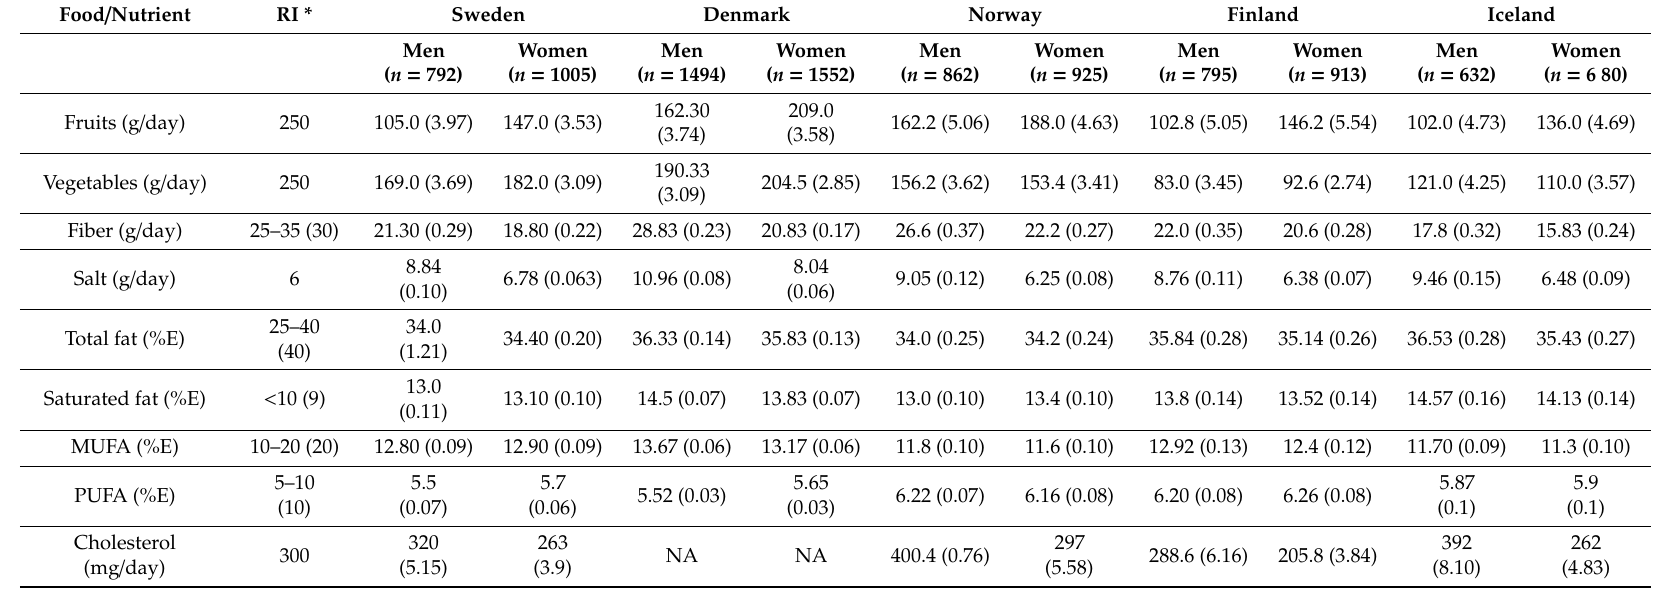
Table 2. Mean dietary component intake versus recommended intake (RI) for men and women in Nordic